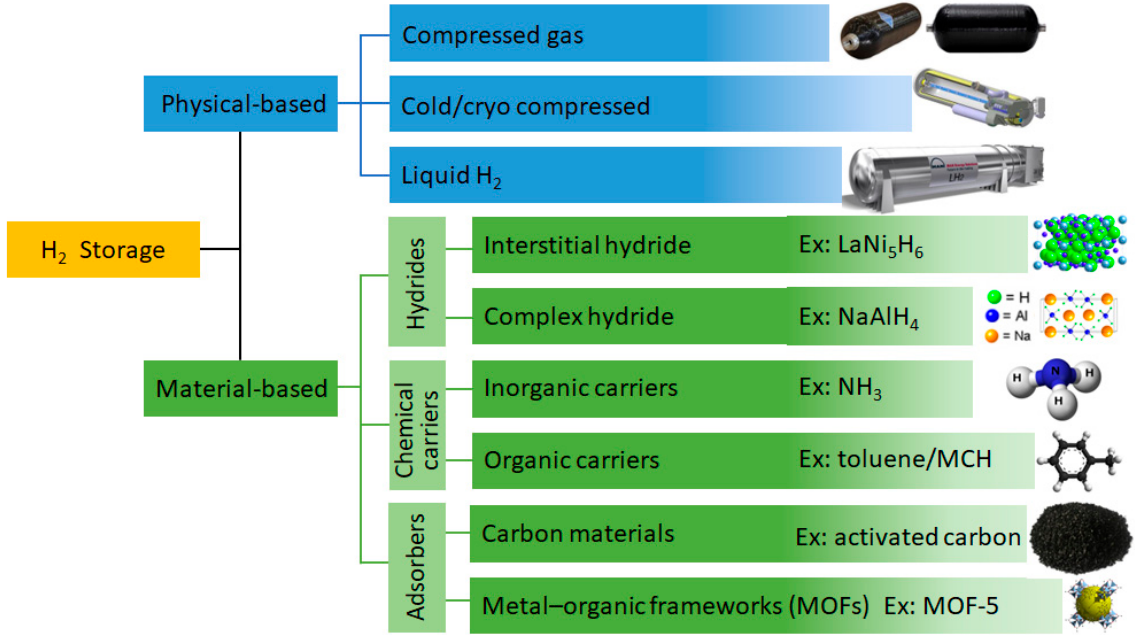
Figure 5. Overview of H 2 storage technologies.